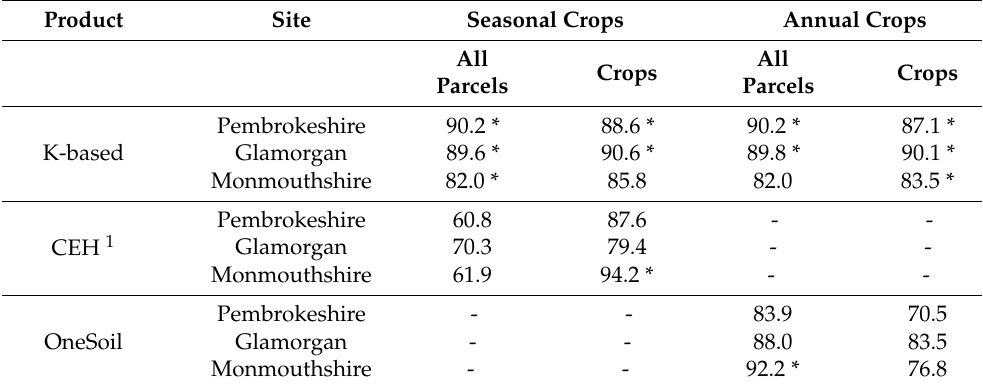
Table 3. Overall, accuracies (%) of the new product (i.e., K-based), CEH, and OneSoil, using farmers’ declarations as ground-truth for Pembrokeshire, Vale of Glamorgan, and Monmouthshire. “Seasonal” indicates the results for the crop map when a distinction is made between winter and spring crop types (e.g., winter barley and spring barley), whereas “annual” indicates that no distinction is made between winter and spring varieties (e.g., barley). “All parcels” indicate that crops as well as grasslands are considered, whereas “crops” indicate that only the crop lands are taken into account. Product Site Seasonal Crops Annual Crops All All Crops Crops Parcels Parcels 90.2 * Pembrokeshire 89.6 * K-based Glamorgan 82.0 * Monmouthshire CEH 1